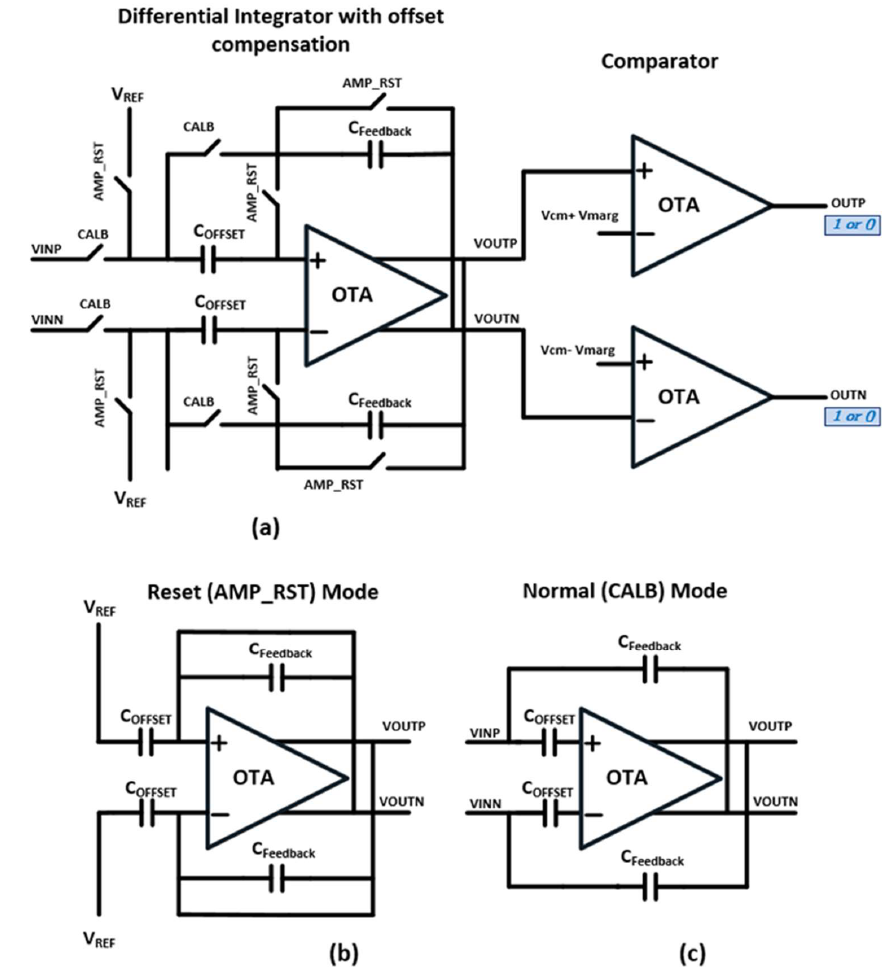
Figure 6. Differential Integrator with offset compensation and Comparator. ( a ) Differential Integrator structure and its configuration in ( b ) Reset Mode and ( c ) Normal Mode.